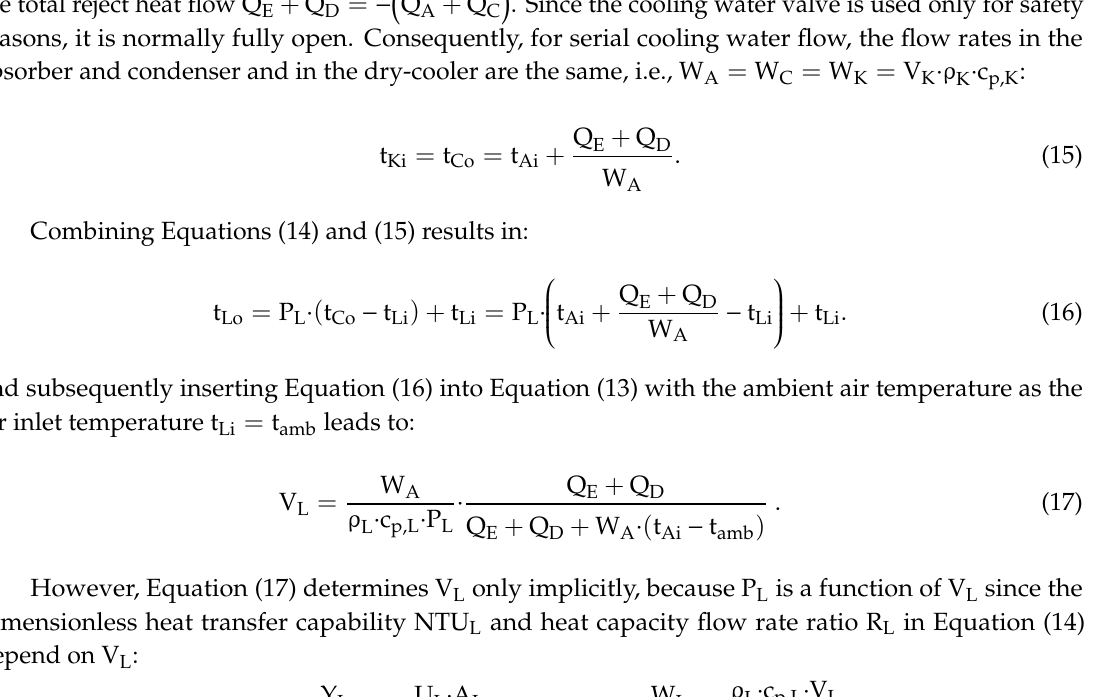
Figure 5. Nomenclature for dry-cooler model.